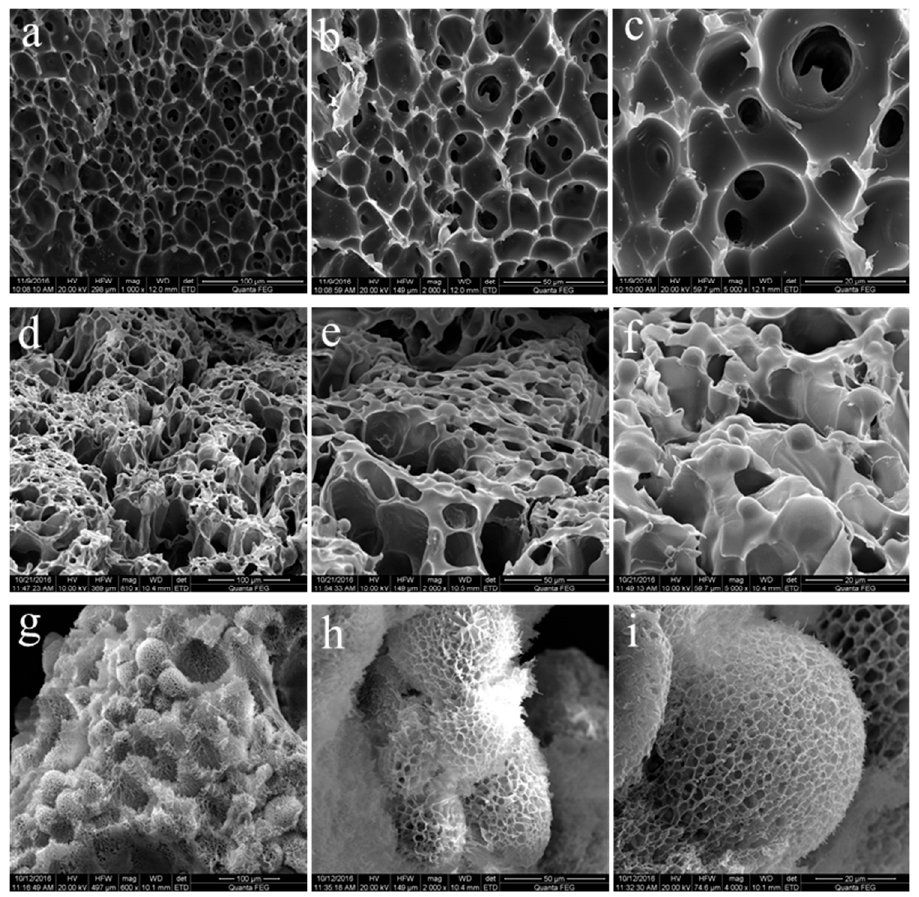
Figure 6. SEM images of hydrogels: ( a – c ) normal hydrogel; ( d – f ) hydrogel containing ordinary microspheres; and ( g – i ) hydrogel containing polymerizable microspheres.